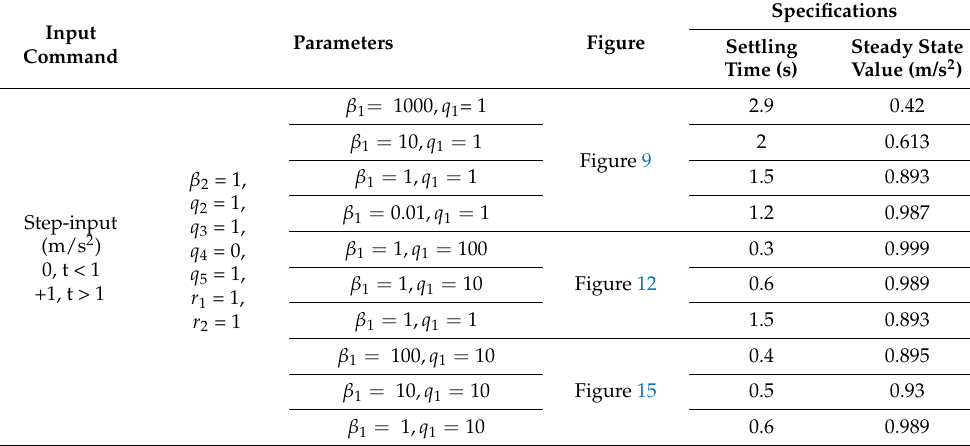
Table 1. The quantitative comparison of specific force.